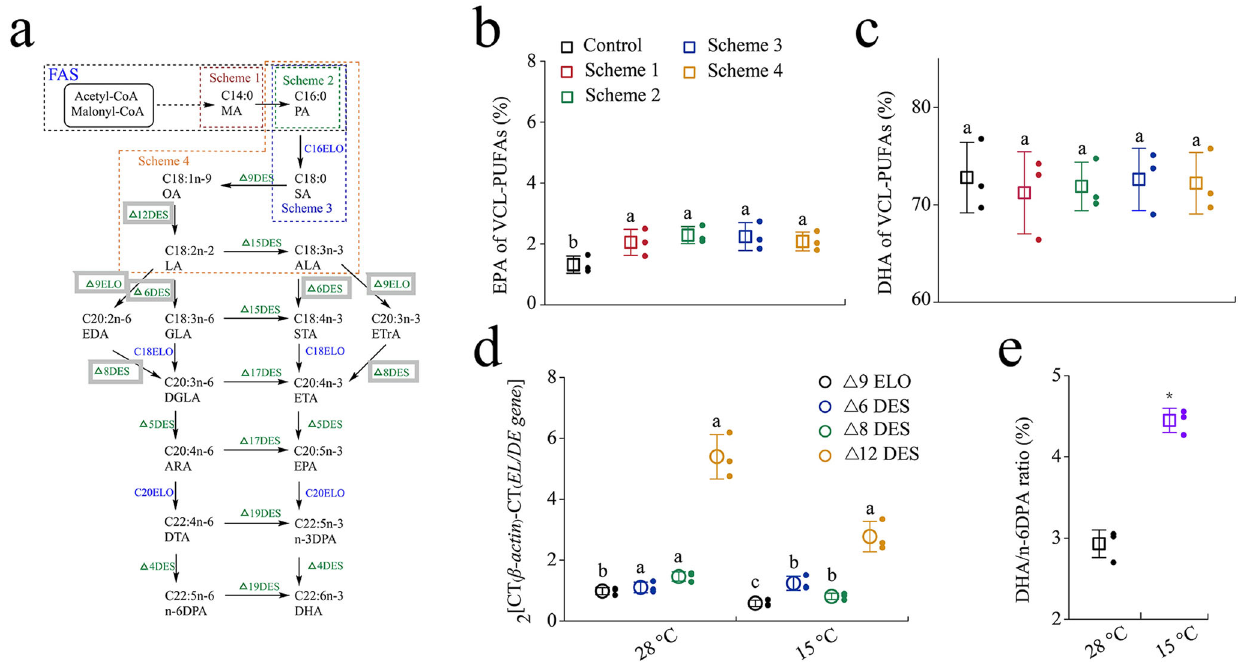
Fig. 2 Elucidating the synthetic pathway of VCL-PUFAs in Schizochytrium sp. a Schematic diagram of the aerobic pathways for VCL-PUFAs biosynthesis. The native EL/DE gene in Schizochytrium sp. is indicated with gray solid frame, and the four addition schemes are marked with colored dotted lines. MA myristic acid, PA palmitic acid, STA stearidonic acid, LA linoleic acid, ALA α -linolenic acid, EDA eicosadienoic acid, GLA γ -linolenic acid, STA stearidonic acid, ETrA eicosatrienoic acid, ETA eicosatetraenoic acid, DGLA dihomo- γ -linolenic acid, DTA docosatetraenoic acid. b , c EPA ratio ( b ) and DHA ratio ( c ) with different addition schemes in Schizochytrium sp. d Comparison of ELO/DES genes transcript level between 28 °C and 15 °C of Schizochytrium sp. (24 h). Letters above the bars indicate signi fi cant difference ( p ≤ 0.05), based on one-way analysis of variance (ANOVA) and Tukey ’ s honestly signi fi cant difference (HSD) test. e Comparison of DHA/n-6DPA ratio between the two temperatures. The statistical signi fi cances of the fi nal results were analyzed by t-test, ∗ p <